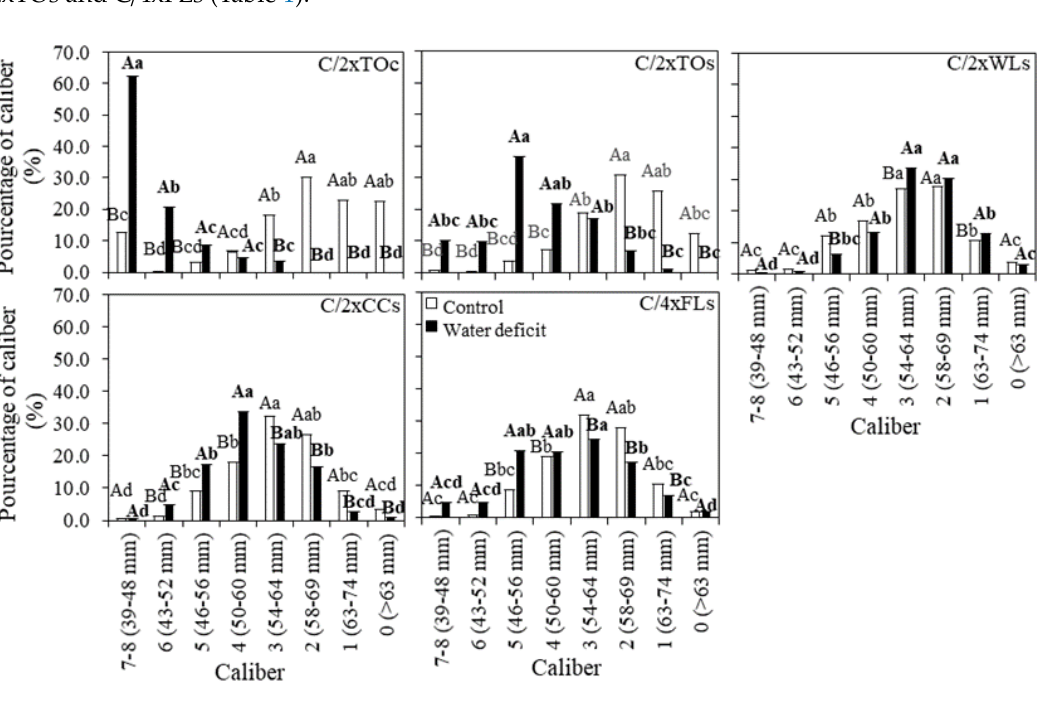
Figure 2. Influence of water deficit on fruit caliber of clementine trees grafted onto di ff erent rootstocks. The tested diploid rootstocks grafted with common clementine were trifoliate orange cutting (C / 2xTOc), trifoliate orange seedling (C / 2xTOs), Carrizo citrange (C / 2xCCs) and Willowleaf mandarin (C / 2xWLs) and FlhorAG1, an allotetraploid somatic hybrid (C / 4xFLs). The white square and the black square correspond to the values obtained under control and water deficit, respectively. All the fruit caliber of clementine trees grafted onto di ff erent rootstocks was measured during the harvesting period (December–January). All data are presented as mean ( ± standard errors (S.E.)) of 3 independent measurements( n = 3). DatawereanalysedusingANOVAandFisherLSDtests( P < 0.05). Di ff erentupper case letters indicate significant di ff erences between control and water deficit for each scion / rootstock combination for a single day and di ff erent lower case letters indicate significant di ff erences between the days for the control or for the water deficit